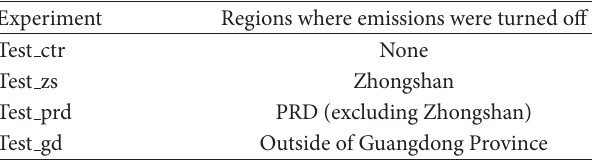
Table 2: A summary of experiment